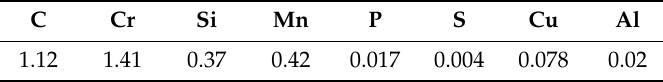
Table 1. Main chemical composition (unit: weight